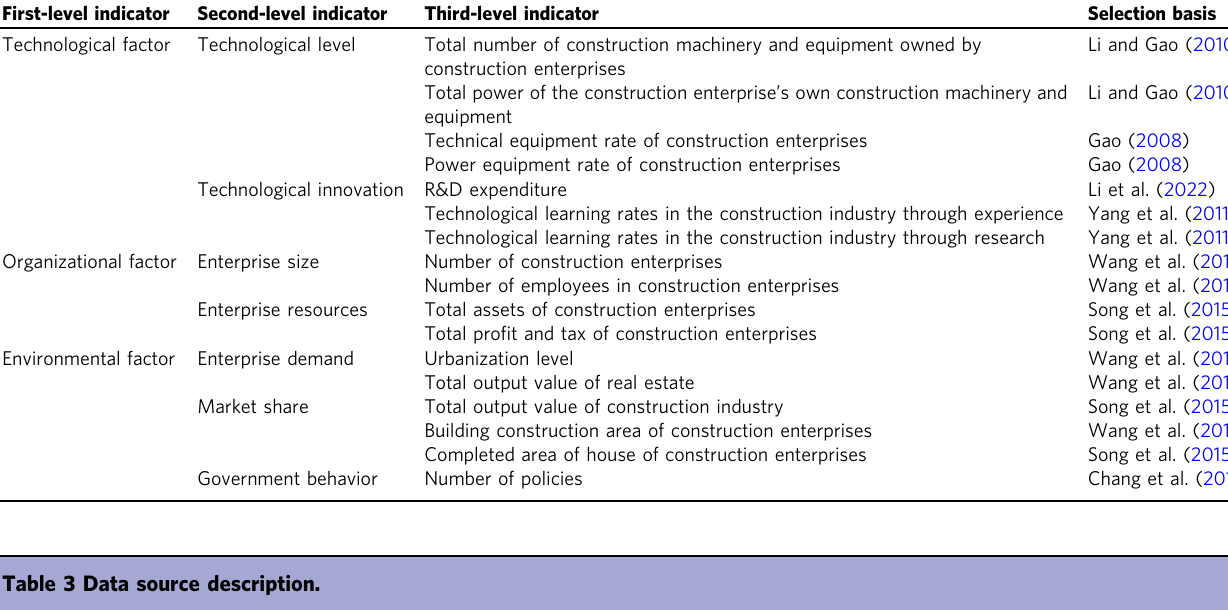
Table 2 Index system of factors in fl uencing construction enterprises ’ adoption of green development behaviors.